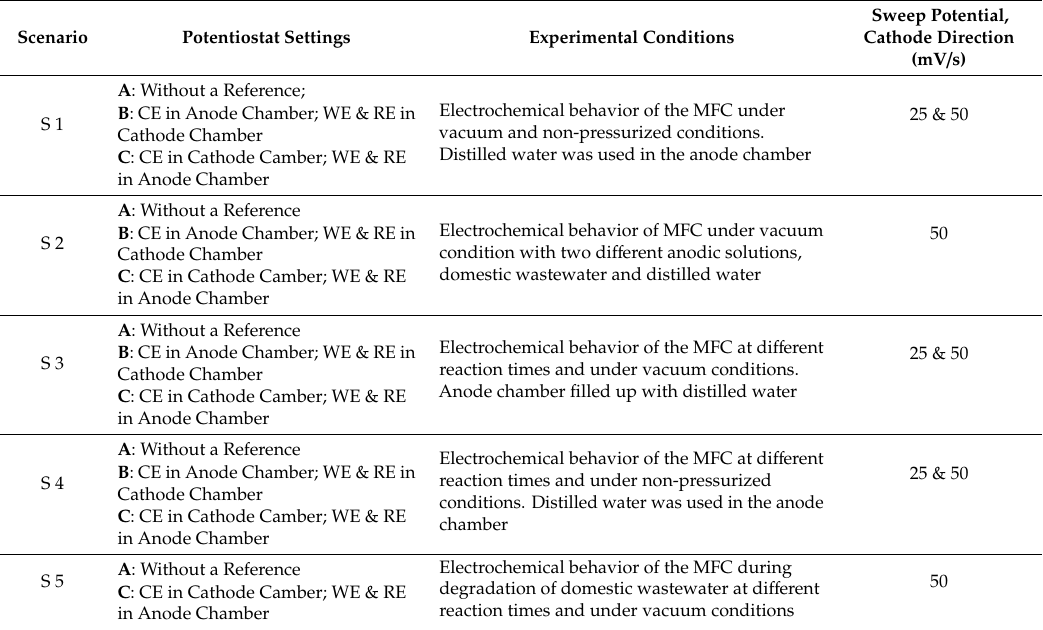
Table 2. Potentiostat settings in each